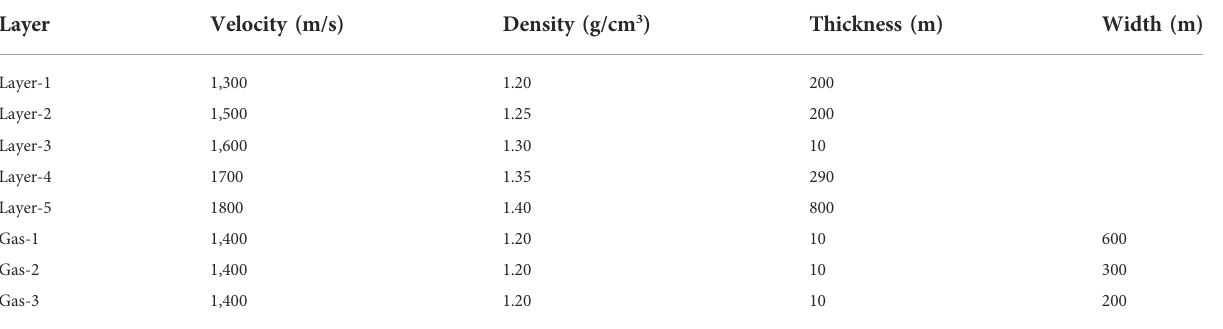
TABLE 1 Geological parameters of the 2-D forward